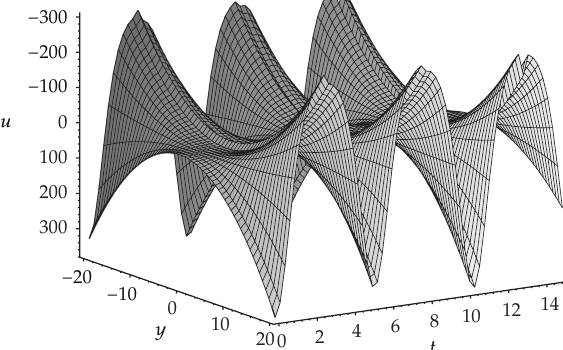
Figure 1: Thestrangephenomenon which is a sympathetic vibration of periodicity on the 𝑡 -axis and paraboloid on 𝑦 -axis for 𝑢 1 (𝑥,𝑦, 𝑡) as 𝑥 = 1